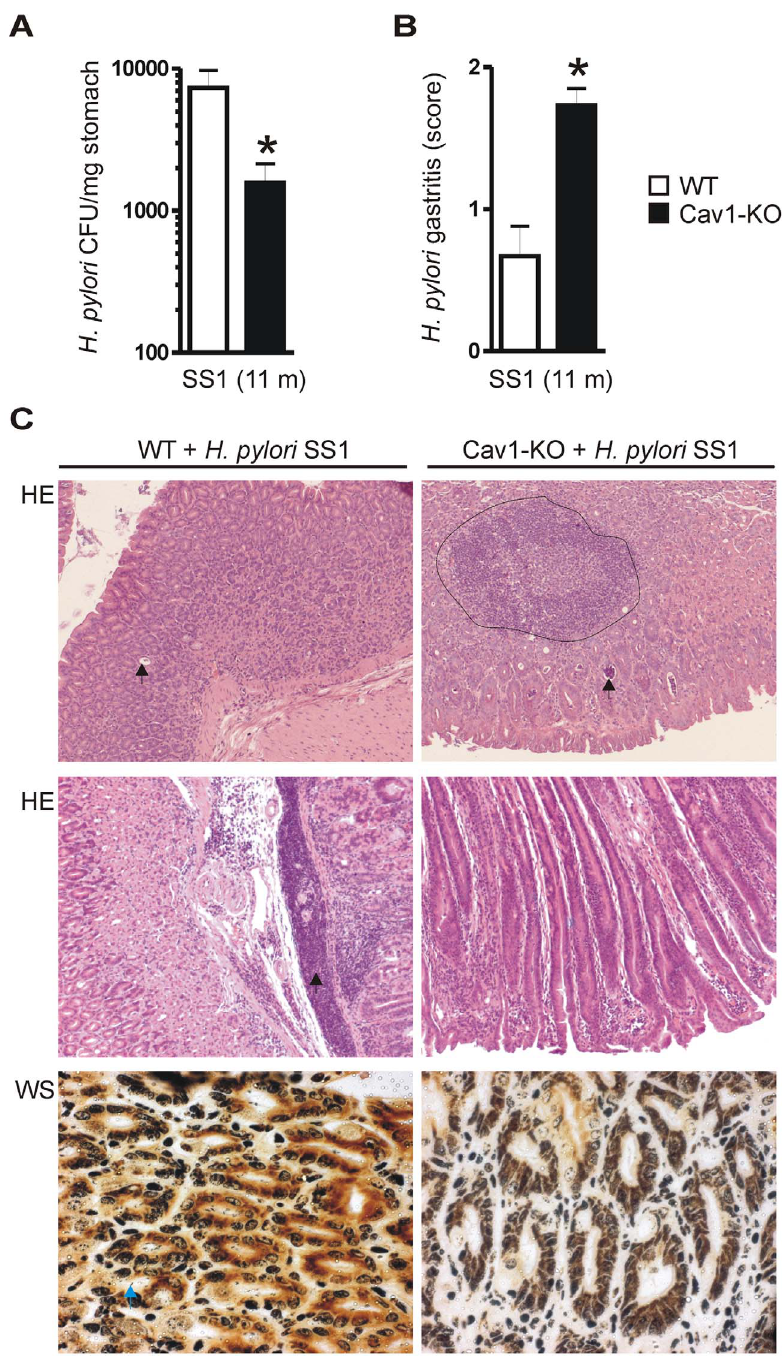
Figure 1. Cav1-deficient mice show enhanced gastritis upon infection with H.pylori SS1. B6129 WT and Cav1-KO mice (n=15 per group) were infected with the mouse-adapted CagA-delivery incompetent H. pylori SS1 strain for 11 month. (A) Stomachs of Cav1-KO mice were less colonized by SS1 bacteria than those of WT mice. Ex vivo quantification of colony forming units (CFUs) per mg of resected stomach tissue. The data are presented as mean 6 S.E. (n=15 per group); *p=0.0141 KO versus WT. (B–C) Hematoxylin & Eosin (H&E) and Warthin-Starry silver (WS) stainings from paraffin sections of mouse gastric tissue were evaluated for signs of histopathology and results were scored for individual mice (0 + no, 1 + mild , 2 + moderate, 3 + severe gastritis). Data are presented as in (A) (n=15 per group); *p=0.0002 KO versus WT. Cav1-KO mice show active chronic gastritis with intramucosal lymphocyte follicles, foveolar hyperplasia and loss of parietal cells. Quantitative analyses (B) are shown together with representative histology (C); magnifications 100 6 , 200 6 .